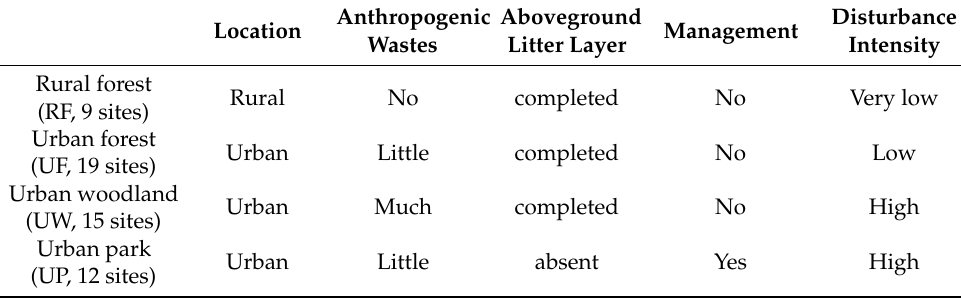
Figure 1. Study area and sampling sites. Table 1. Classification based on ecosystem types and disturbance